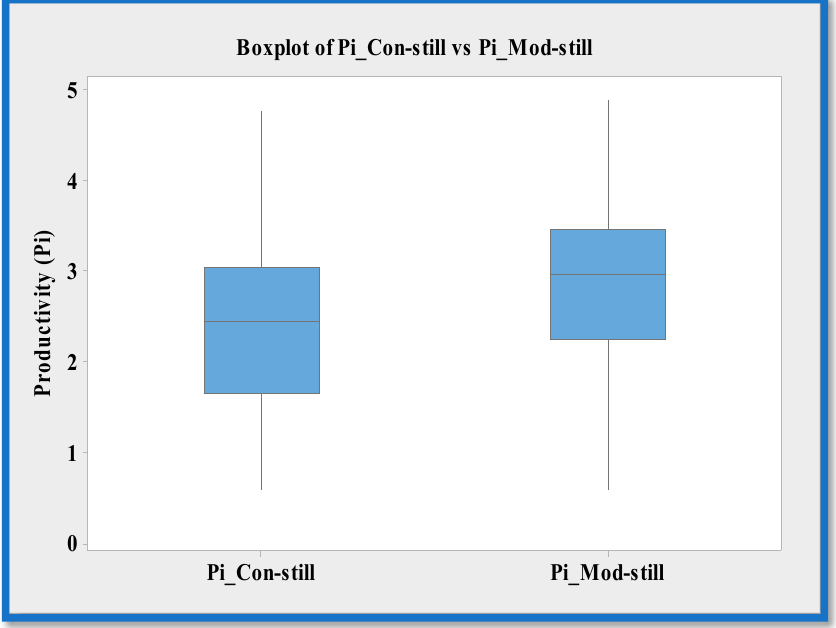
Figure 8. Boxplot of Pred_Obs Ratio of Models 1, 2, and 3 (mod-still). (* represents outlier data).